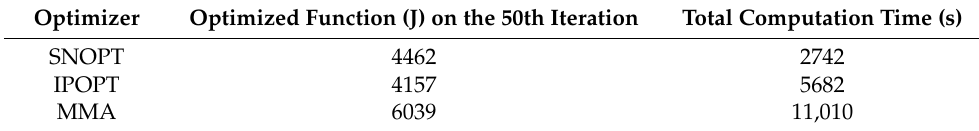
Table 1. Computational times for the three